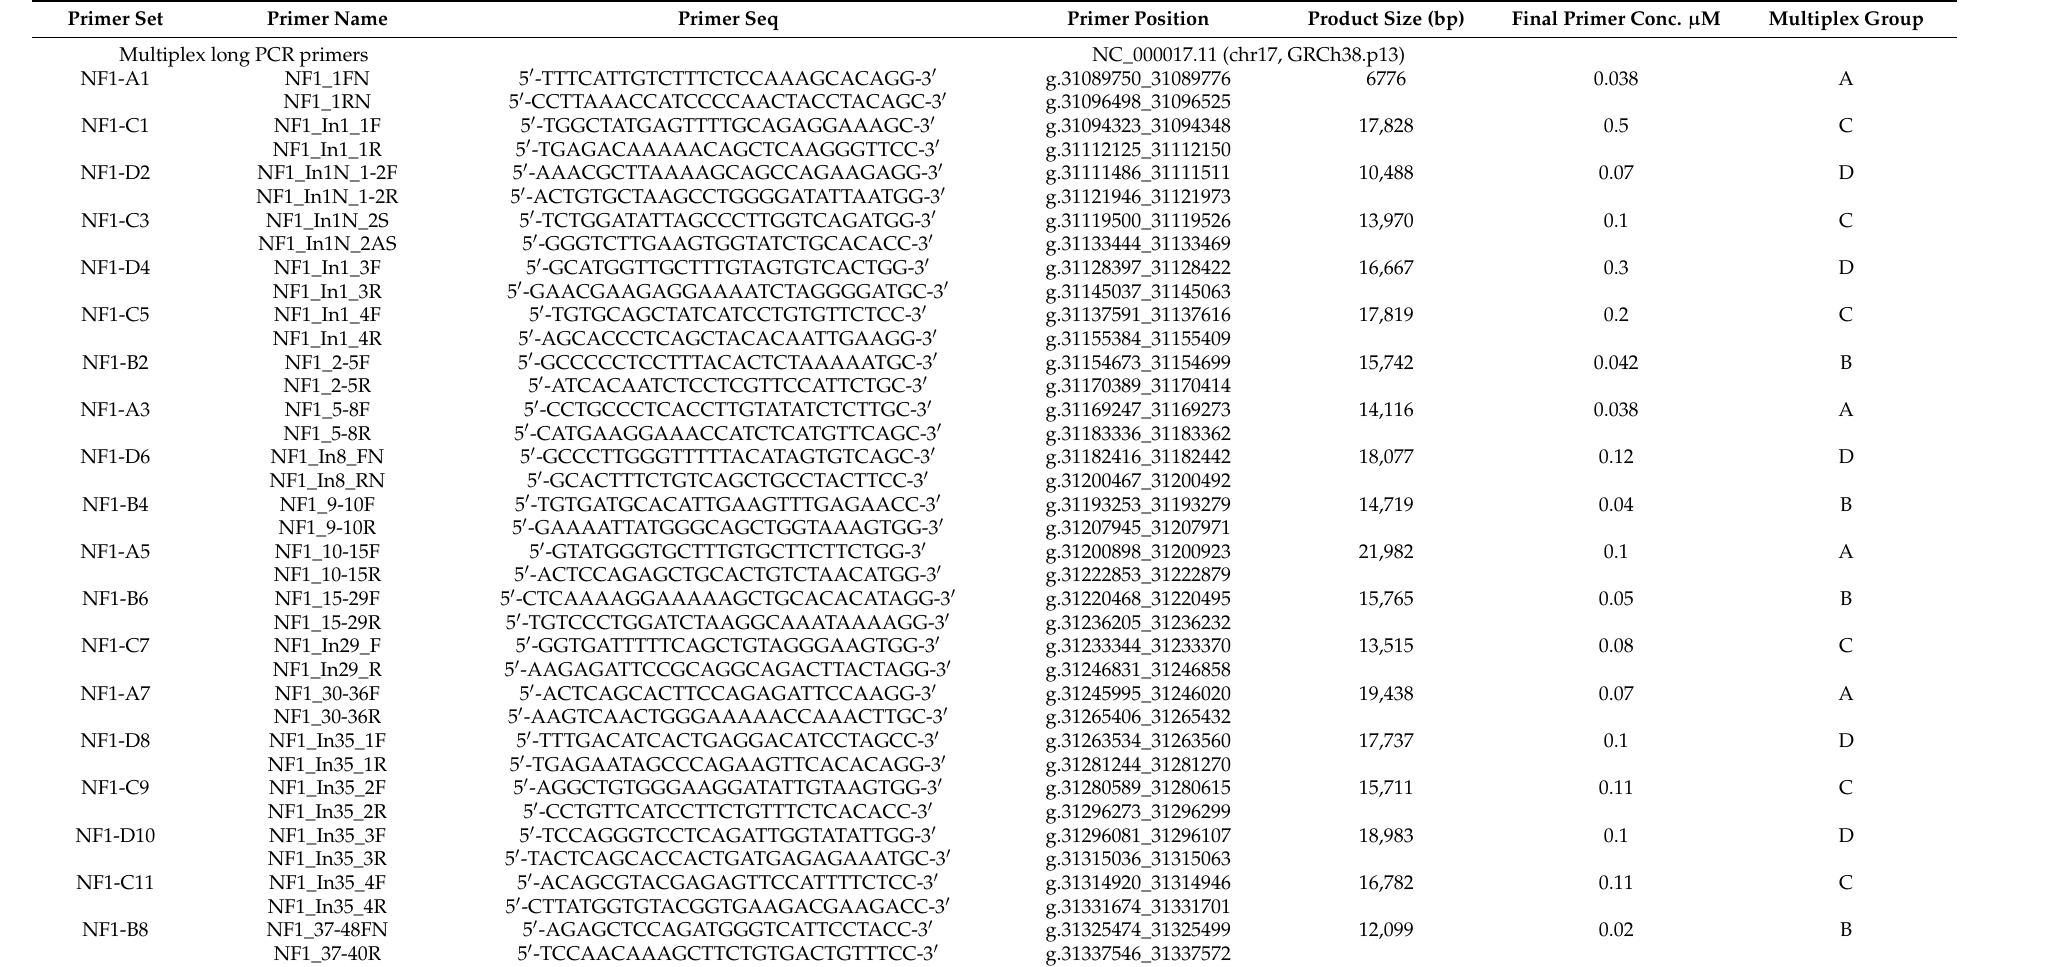
Table 1. Long PCR primers for NF1 genetic